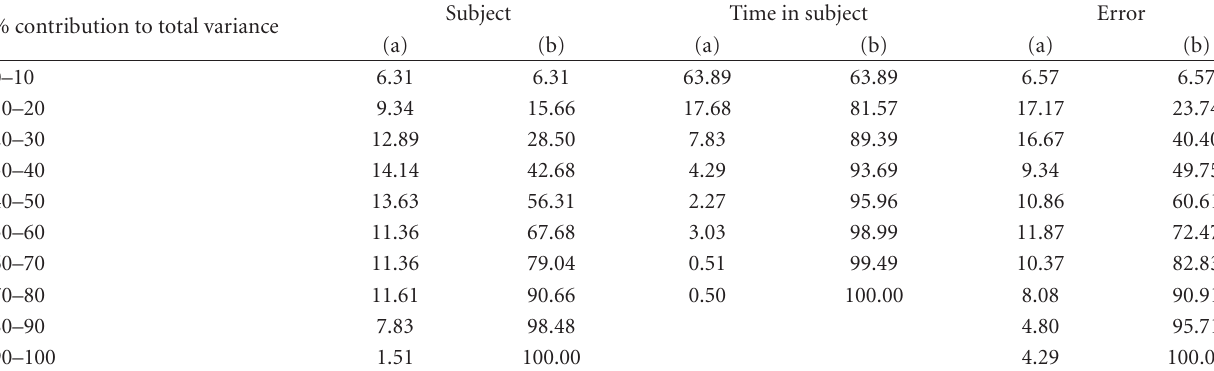
Table 1: Frequency distribution of the variance component estimates.